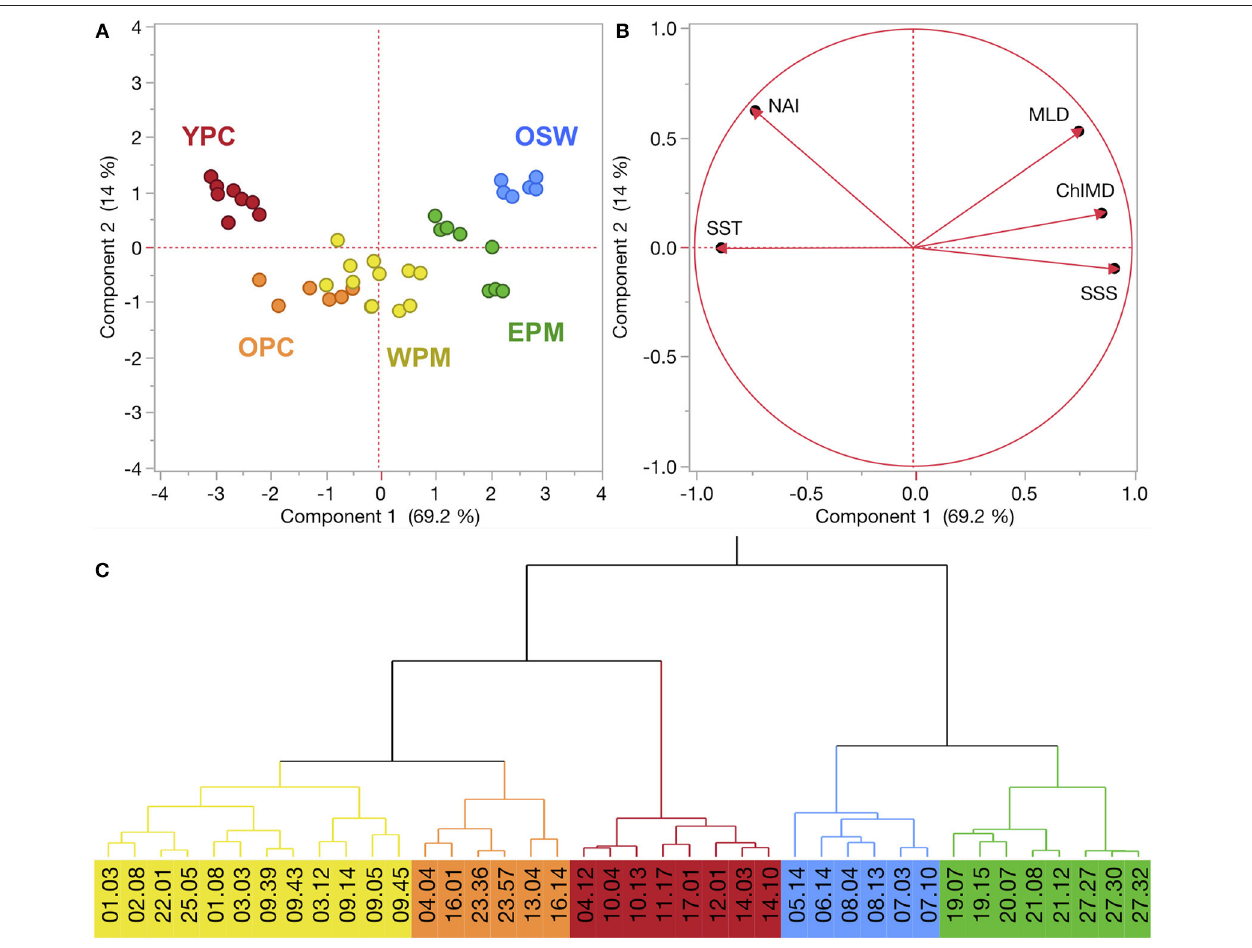
FIGURE 2 | (A,B) Principal component analysis (PCA) of KN197-8 CTD casts from the WTNA based on the habitat-type defining variables (see text for explanation). The score plot (A) is a scatter plot of each cast’s score according to the first two principal components, where colors correspond to habitat types. % variation explained by PC1 and PC2 is listed on their respective axes. The loading plot (B) shows the unrotated loading matrix between the analyzed variables and the first two principal components. The closer a variable’s loading value is to 1, the greater the effect of the variable on that component. (C) Wards-mean hierarchical cluster analysis based on the habitat-defining variables. Habitat types are identified by color: young plume core (YPC), old plume core (OPC), western plume margin (WPM), eastern plume margin (EPM), and oceanic seawater (OSW). ( Figure 3A ) and properties. The PCA ( Figure 2 ) and summary of environmental variables by habitat type ( Table 1 , Figure S2 ) indicate that the habitat types are arrayed along a continuum of the habitat-defining variables, with the nearshore Amazon River water (YPC) at one extreme and oceanic waters (OSW) at the other. Along this continuum, SST decreases whereas SSS, MLD, and ChlMD all increase. In contrast, NAI is similar across all but the YPC habitat, where nitrate availability is much higher due to rather shallow nitraclines. Note that nitrate availability is important in differentiating the YPC and OPC habitat types. The WTNA habitat types are largely distinct geographically ( Figure 3A ), with YPC nearest the river mouth and OSW offshore to the east and well out of the path of the river plume. OPC and WPM habitats overlap geographically and in PCA space, though OPC is distinct from WPM based on its much fresher surface waters ( Figure S2 ). The EPM habitat is located farther offshore and to the east of the OPC and WPM